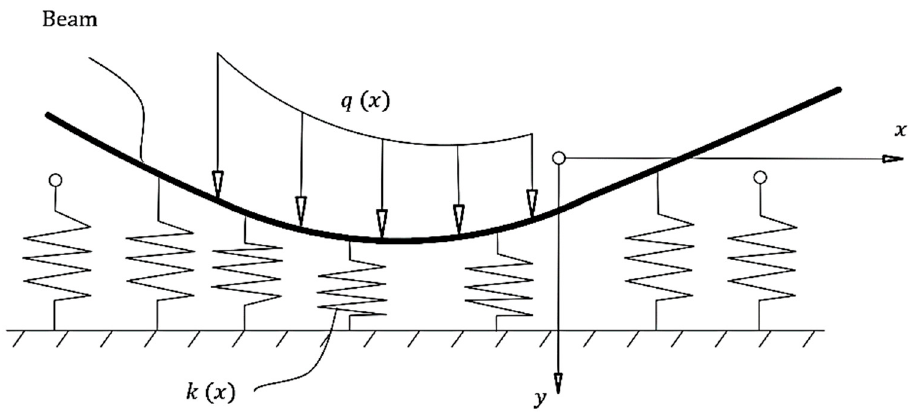
Figure 2. A free–free beam resting on tensionless foundation. With the shown idealized deformation in Figure 2, it can be seen that the beam is lifted (separated) from the elastic spring supports at both ends. This can also be shown in a more simplified diagram as in Figure 3. Here the origin is located at the middle of the beam and the lifted zone from the left is represented by α l L /2 and from the right by α r L /2. In this case, the subgrade reaction can be expressed mathematically by Equation (1).